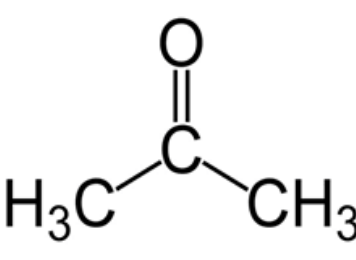
Figure 1. Chemical structure of acetone.